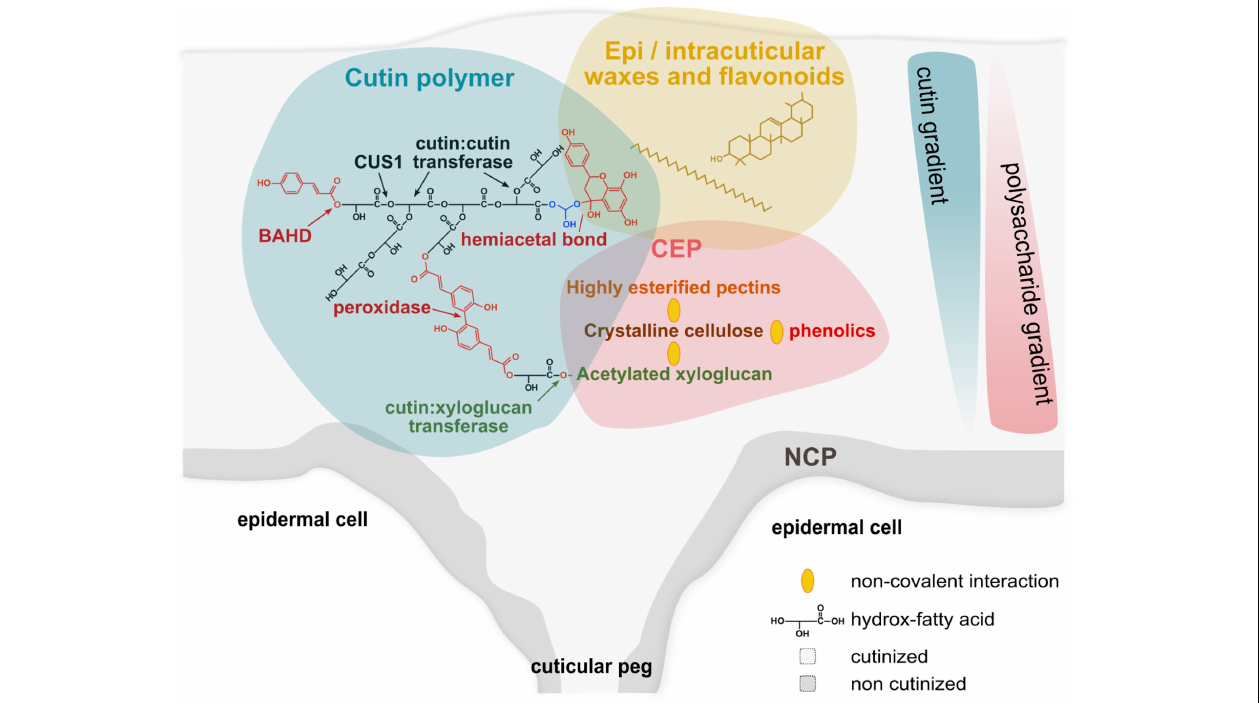
FIGURE 1 | Schematic model for the complex architecture of plant cuticles. Plant cuticle (gray background) is a natural hydrophobic composite. The lipid scaffold of the cuticle is the cutin polymer (blue background) embedded with waxes (yellow background), and associated to the cuticle-embedded polysaccharides (CEP, red background). Cutin is a polyester network of HOFA mainly formed by the activities of CUS1 (a protein from the multigenic GDSL family of esterase/lipase) (Girard et al., 2012) and cutin:cutin acyl transferase (CCAT, the protein associated with this activity has not yet been identified) during the expansion of the plant cuticle (Xin et al., 2021). Para-coumaric acid esterification of the primary alcohol group of HOFA (co-position) is catalyzed by an enzyme of the multigenic BAHD family (Molina and Kosma, 2015) and could form covalent bridges between the polyester chains through peroxidase oxidation (Kerr and Fry, 2004; Arrieta-Baez and Stark, 2006). The strong association of flavonoids (e.g., naringenin and naringenin chalcone in tomato), especially at the end of fruit growth (Hunt and Baker, 1980) could involve hemiacetal bond with primary hydroxyl groups (e.g., with the glycerol end residue of 2-monoacylglycerol, the precursor of CUS1). The cutin:xyloglucan transferase is a good candidate to link covalently the cutin network to the CEP (Xin and Fry, 2021). In contrast to the non-cutinized polysaccharides (NCP), the CEP concentrates crystalline cellulose, highly esterified pectins and acetylated xyloglucans (Philippe et al., 2020) associated by non-covalent bonds (yellow ellipses). In addition, the hydrophobicity of these polysaccharides is compatible with non-covalent interactions (Ngouémazong et al., 2015; Dai et al., 2020; Lindman et al., 2021) with the cutin network and intracuticular waxes. Finally, cellulose can also interact with phenolics (Phan et al., 2015). The cutin network and CEP form gradients in the